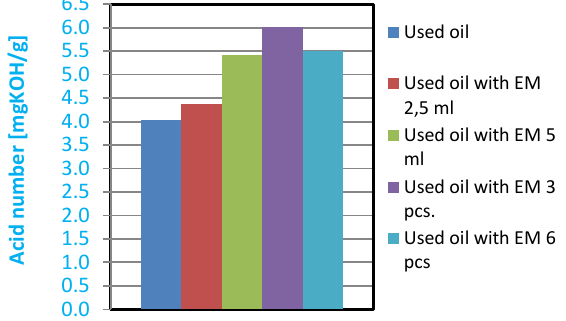
Fig. 3. Acid number of used oil and used oil with EM in liquid form and ceramic tubes The effective microorganisms in the form of ceramic